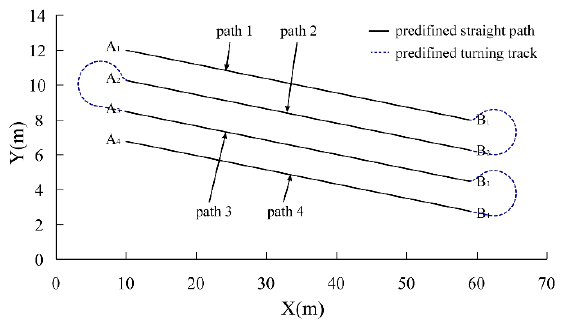
Figure 9. Autonomous navigation predefined path.